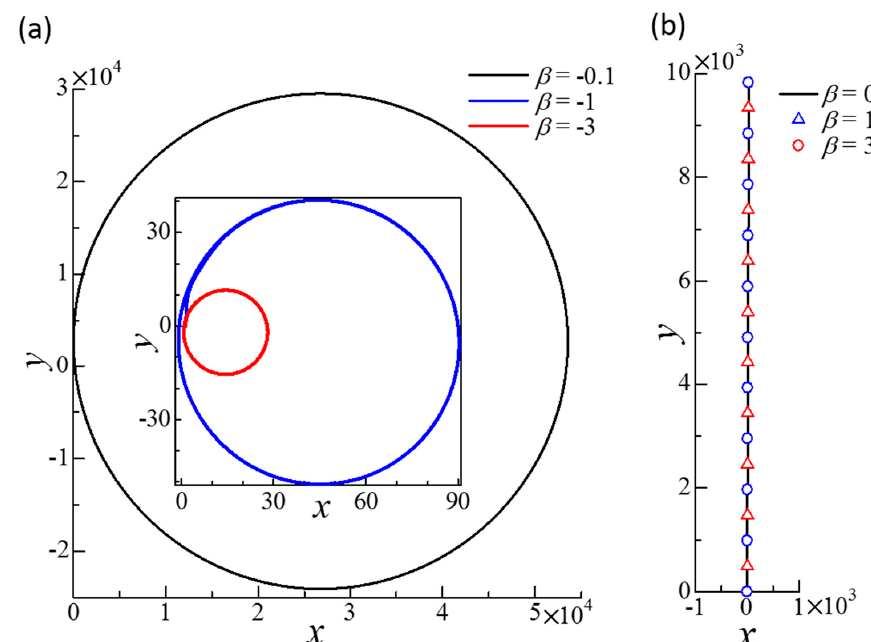
Figure 7. Effect of β on the trajectories of the squirmer centers of dumbbell squirmers connected side-by-side. To generate a small disturbance, two squirmers were initially placed at r c = (0, 0, 0) and r c = (3 a , 0, 0.1 a ) with φ 1 = 1 ◦ and φ 2 = 2 ◦ . The equilibrium length of the spring was set at a . ( a ) Circular trajectories obtained in negative β cases. Inset shows the cases β = − 1 and − 3. ( b ) Straight trajectories obtained for β = 0, 1, and 3.